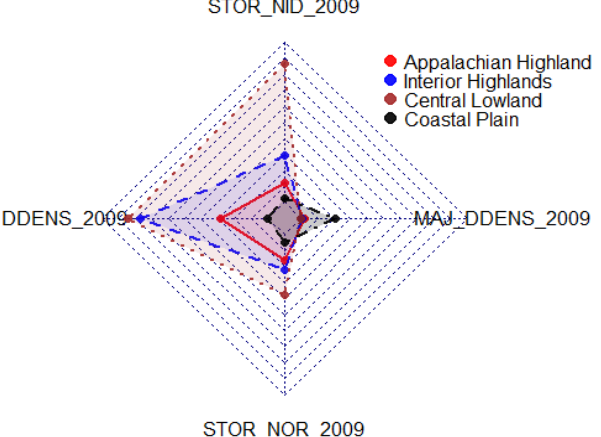
Figure 13. Comparison of importance levels for dam variables (ranking 1 to 10) common to more than one region.